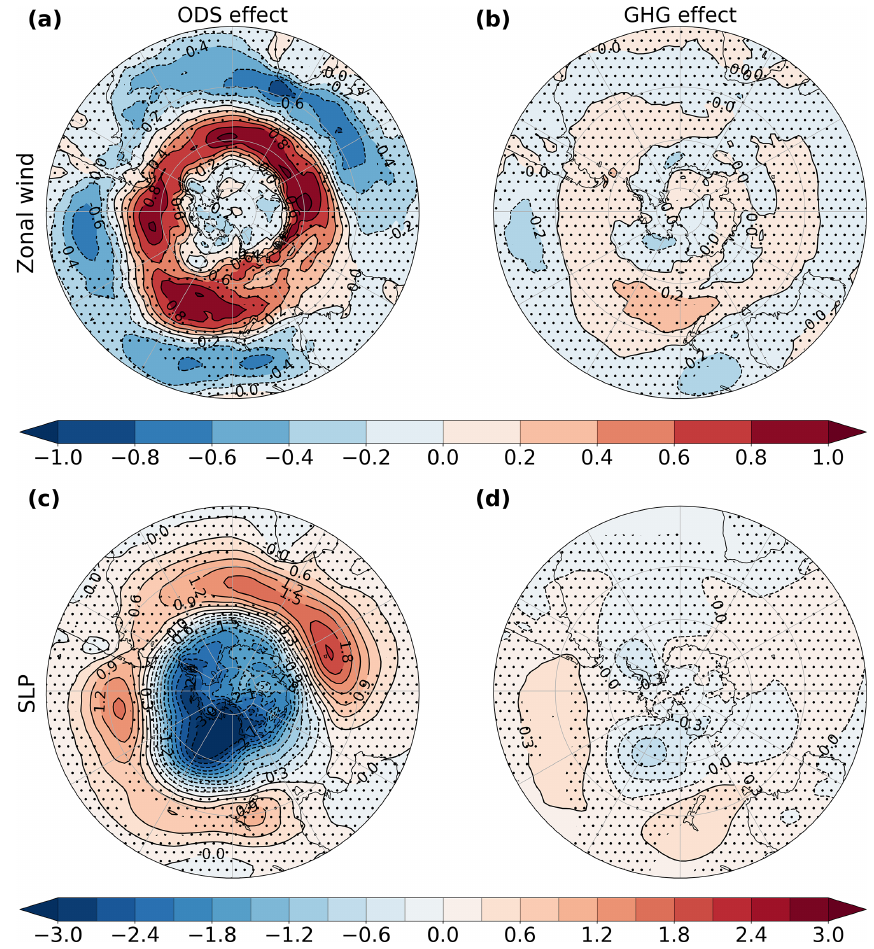
Figure 3. Polar stereographic maps of the November–December difference between REF and NoODS (a, c) and the annual mean difference between REF and NoGHG (b, d) in the surface zonal wind ( a, b ; ms − 1 ) and in sea level pressure ( c, d ; hPa) for the period 1978–2002. Stippling masks values that are not significant at the 95% confidence